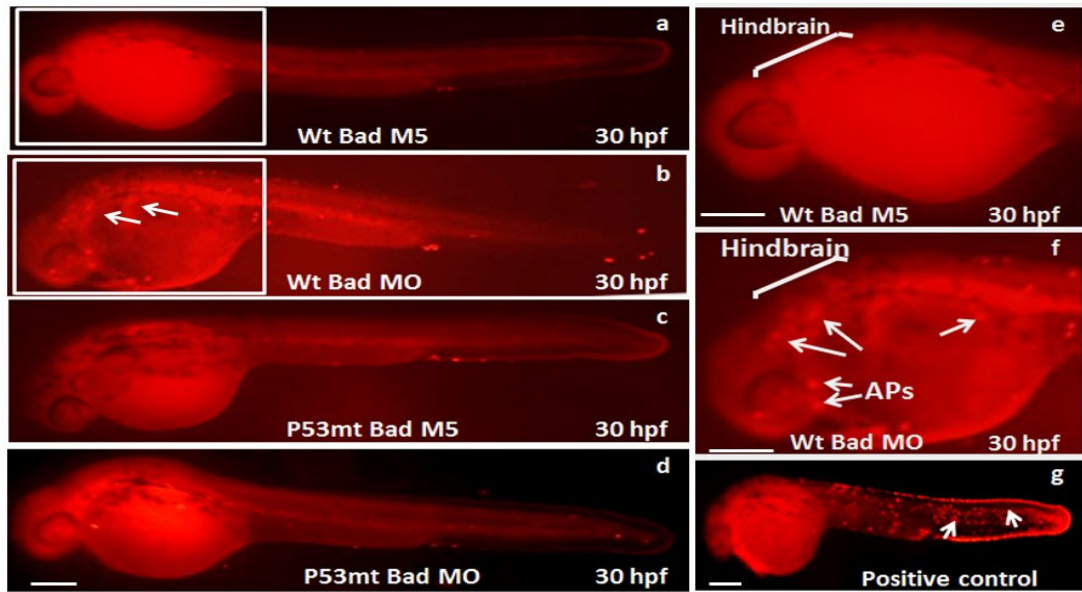
Figure 3. Identification of p53-mediated stress signaling can regulate apoptotic cell death during Bad knockdown in p53 mutant ( p53 M214K ) zebrafish lines. Identification of TUNEL-positive cell death patterns in different fish lines at the 30 hpf stage. In the different fish lines ( a – f ), the TUNEL-positive cell deaths (APs), especially in the hindbrain area, are indicated by arrows. The positive control treated with hydrogen peroxide is shown in panel ( g ). Scale bar = 200 µ m.